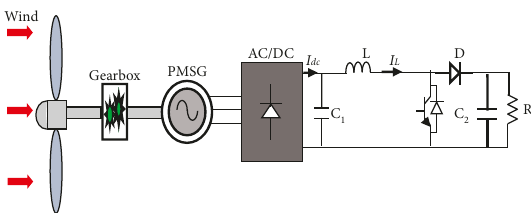
Figure 1: Wind energy conversion system structure.